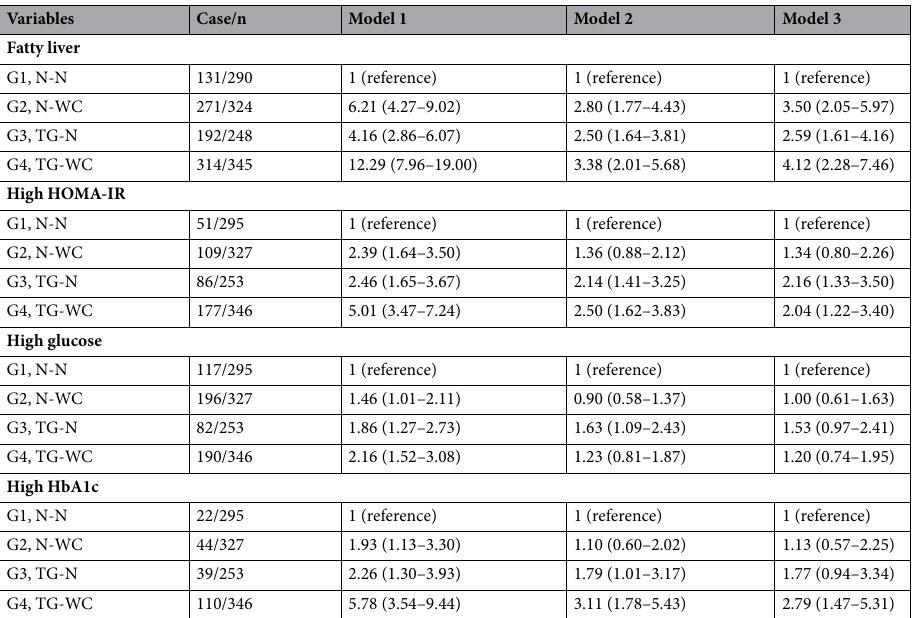
Table 2. Association of hypertriglyceridemic waist phenotype and fatty liver and glycometabolic profile. Data expressed as odds ratio (OR) ([95% confidence interval [95% CI]). Model 1 is crude model without adjustment; Model 2 adjusted for age, sex and body mass index (BMI); Model 3 further adjusted for potential lifestyle (smoke, alcohol, physical activity and sedentary time); G1, N-N, normal TG & normal WC; G2, N-WC, normal TG & high WC; G3, TG-N, high TG & normal WC; G4, TG-WC, high TG & high WC. HOMA-IR, Homeostatic Model Assessment of Insulin Resistance index; HbA1c, glycosylated hemoglobin. High WC was defined as ≥ 102.0 cm for males and ≥ 88.0 cm for females, high TG as ≥ 1.71 mmol/L, high HOMA-IR as ≥ 3.19, high glucose as ≥ 5.6 mmol/L, and high HbA1c as ≥ 6.5%. Overweight was defined as 24.0 ≤ BMI < 28.0 kg/m 2 , obesity as BMI ≥ 28.0 kg/m 2